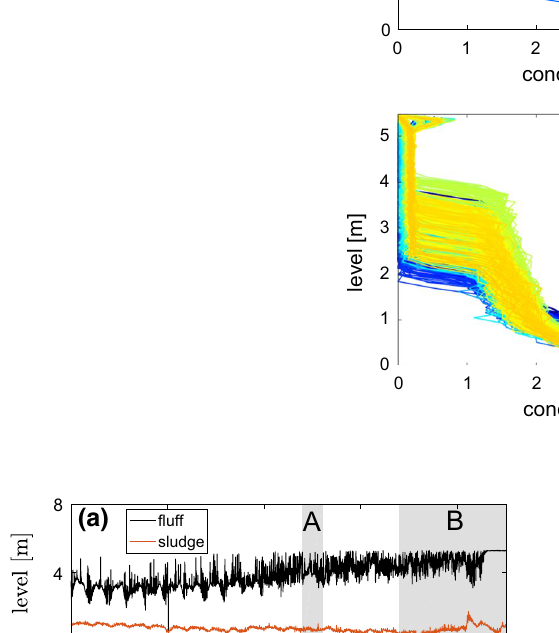
Fig. 3 Sludge profiles during the SST monitoring. a after 5 days; b after 10 days; c after 15 days; d after 20 days. First days coloured in dark blue, last days in dark red